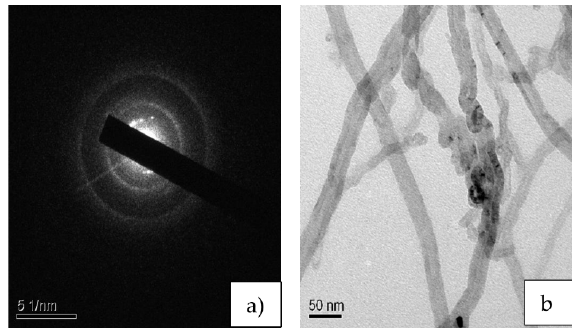
Figure 1. ( a ) SAED pattern; ( b ) TEM of CNTs.